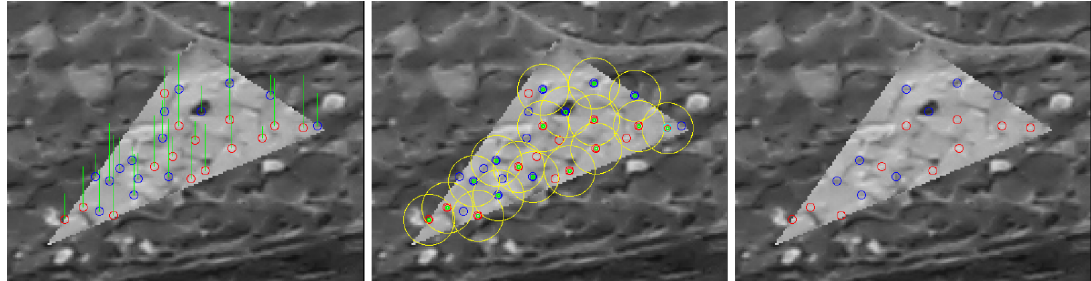
Figure 15. Tie-point spatial filter applied in the priority of points score C GCS with their score illustrated in green line, ( Middle ): filter space area in the yellow circle, ( Right ): Points after